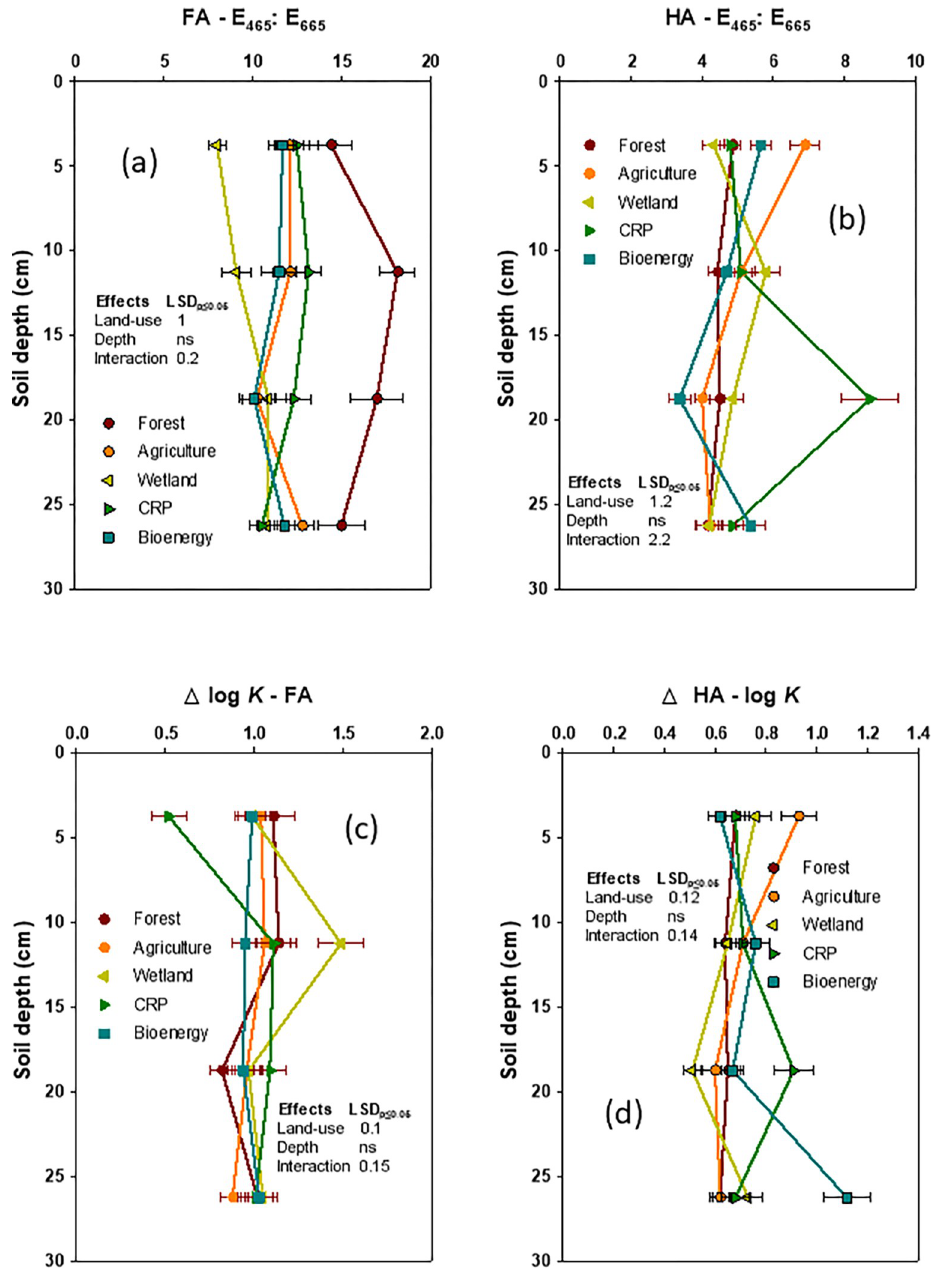
Fig 4. Impact of deforestation and subsequent land-use diversity on spectral characteristics of fluvic acid (FA) and humic acid (HA) components of total organic carbon at different soil depths (data were presented with mean ± standard